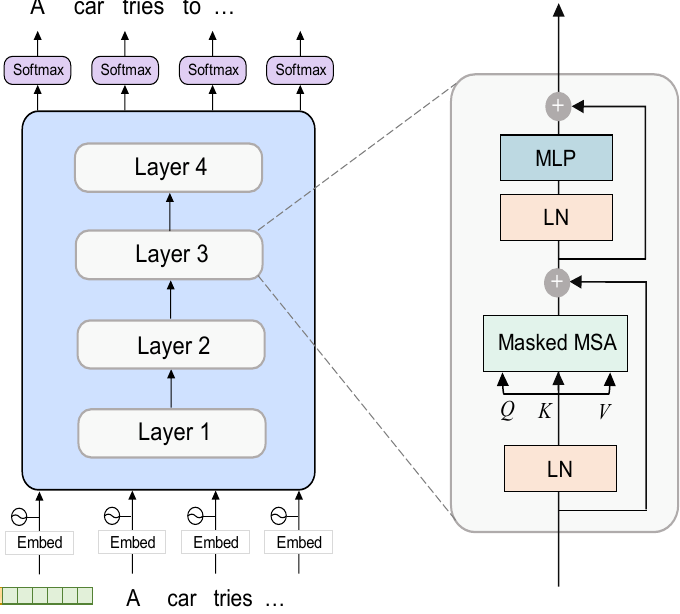
Figure 5. The architecture of the language Figure 5 . The architecture of the language decoder.